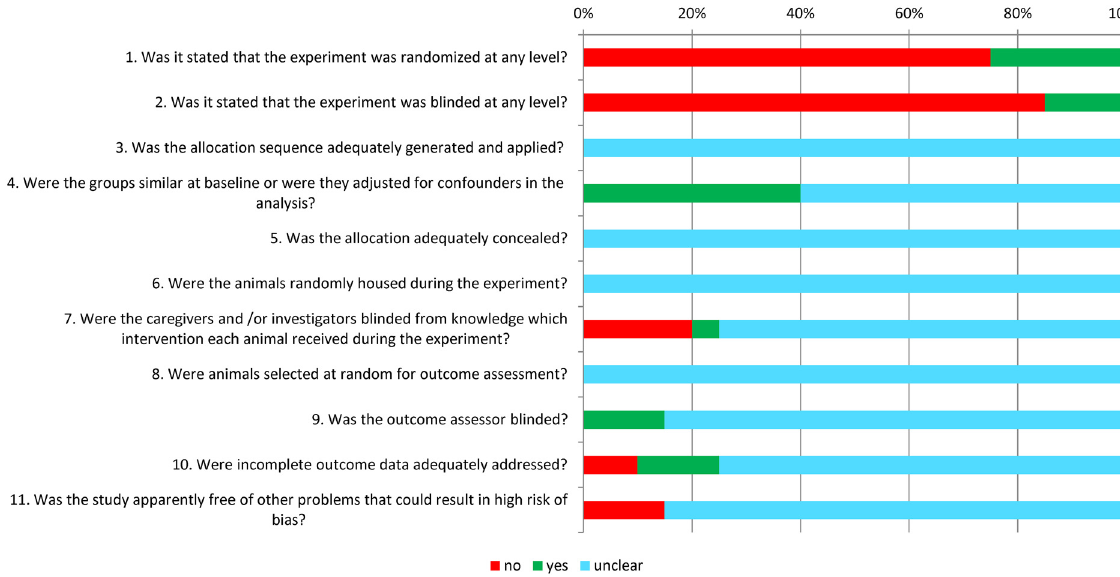
Fig 2. Results of the risk of bias assessment of the 19 studies included in this systematic review. The first two items assess study quality by scoring reporting, a ‘ yes ’ score indicating reported, and a ‘ no ’ score indicating unreported. The other items assessed risk of bias, with ‘ yes ’ indicating low risk of bias, ‘ no ’ high risk of bias and ‘ ? ’ unclear risk of